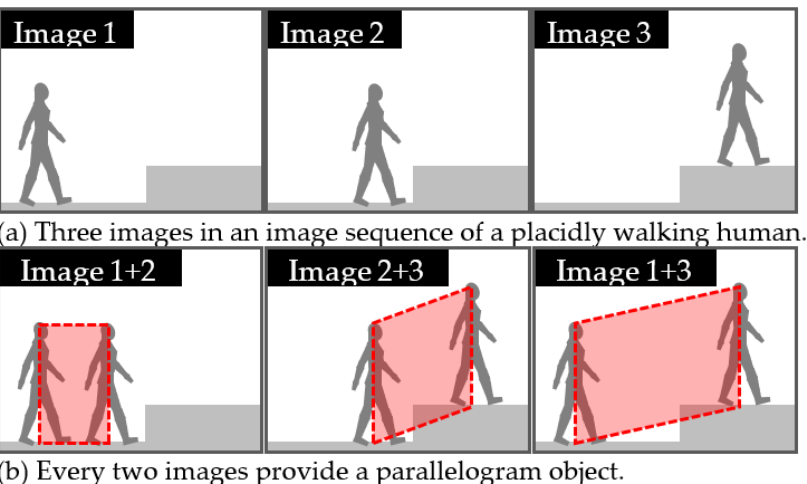
Figure 6. Parallelogram objects obtained from an image sequence of a placidly walking human. Author Contributions: Conceptualization, X.Y. and Y.S.; methodology, Y.S.; software, X.Y.; valida-